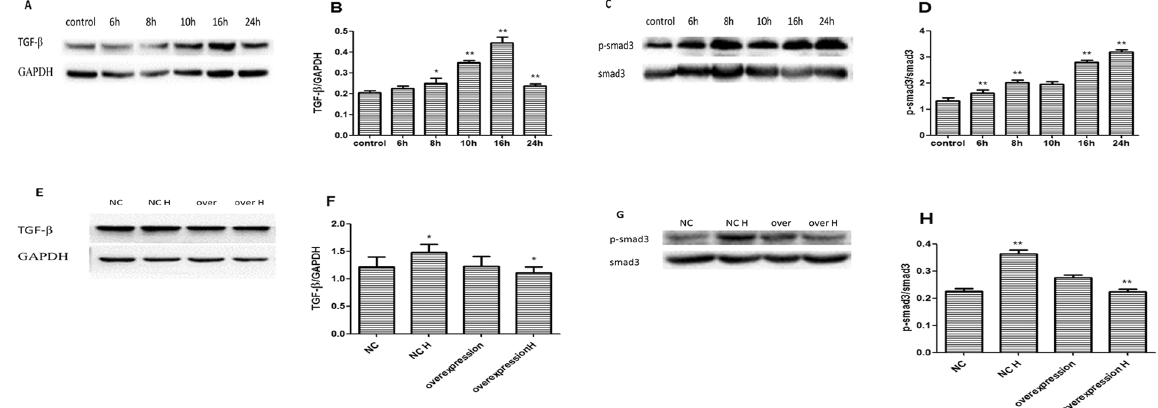
Figure 7. ANO1 inhibits cardiac fibrosis via TGF- β /smad3 pathway. ( A and B ) At 6, 8, 10, 16, and 24 hours after hypoxia, TGF- β protein levelwas gradually increased compared to untreated group, peaked at 16 and 24 hours by western blotting analysis. ( C and D ) At 6, 8, 10, 16, and 24 hours after hypoxia, p-smad3protein levelwas gradually increased compared to untreated group, peaked at 16 and 24 hours by western blotting analysis. ( E ) and ( F ) After cardiac fibroblasts were tranfected by Ad-GFP-ANO1 and exposed in the present or absent hypoxia, TGF- β protein level was decreased in overexpression H group comparing to overexpression group or negative control hypoxia (NC H) group by western blotting. ( G and H ) After cardiac fibroblast were tranfected by Ad-GFP-ANO1 and exposed in the present or absent hypoxia, TGF- β protein level was decreased in overexpression H group comparing to overexpression group or negative control hypoxia (NC H) group by western blotting. * p < 0.05, ** p <